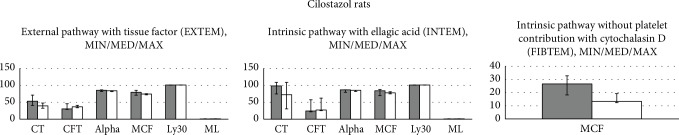
Rats which underwent antithrombotic agent cilostazol (10 mg/kg intragastrically, once daily for three days) received immediately thereafter BPC 157 (10 μg/kg intragastrically, once daily for three days) (white bars) or an equal volume of saline (5 ml/kg, intragastrically, once daily for three days) (gray bars); they were sacrificed at 2 h after the last application. Viscoelastic properties of the blood were assessed using modified rotational thromboelastometry (TEM) on ROTEM® delta analyzer (Tem International GmbH, Germany). Typical parameters obtained are clotting time (CT), the time from the beginning of measurement until the clot starts to form; clot formation time (CFT), the time needed for the clot to reach an amplitude of 20 mm; alpha-angle, angle of tangent at 2 mm amplitude; maximum clot firmness (MCF), the maximum amplitude of the curve during 60 minutes of measurement; Ly30, clot lysis at 30 minutes; and maximum lysis (ML) which describes the percentage of the maximum lost clot firmness relative to MCF. We analyzed external pathway with tissue factor (EXTEM), an intrinsic pathway with ellagic acid (INTEM), or without platelet contribution with cytochalasin D (FIBTEM). After 60 minutes CT, CFT, alpha-angle, MCF, Ly30, and ML were recorded. P > 0.05, vs. control.